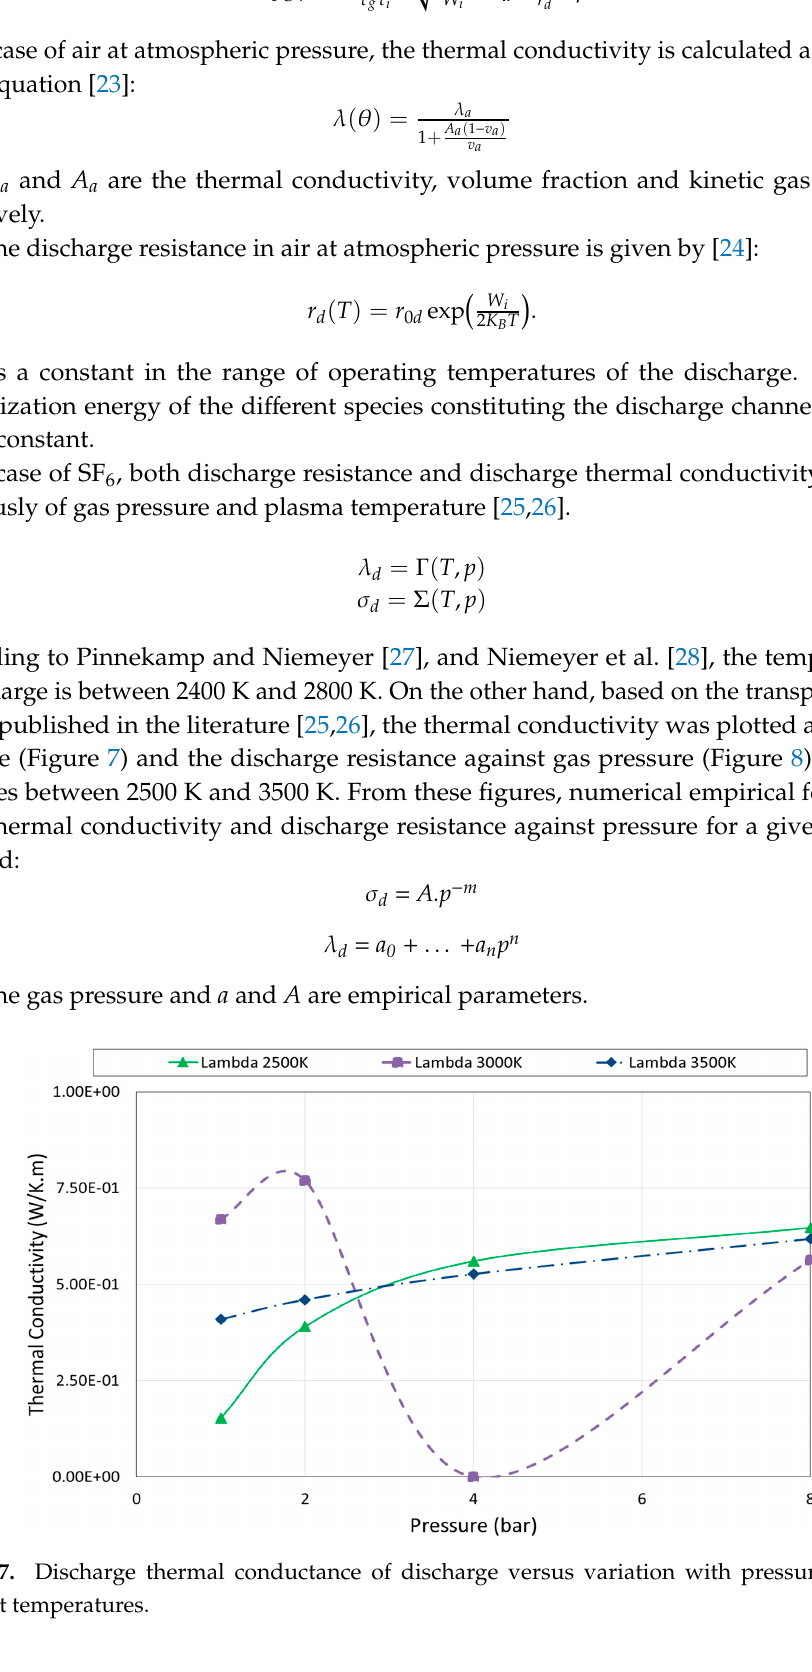
Figure 8. Discharge resistance variation versus pressure with different temperatures at 2500 and 3000 K, respectively. 4. Application To validate the proposed model, first the model was applied for the calculation of the flashover voltage of cylindrical epoxy insulators in air at atmospheric pressure. The second application will be for the same kind of insulator in SF 6 gas medium. The computed flashover voltages are compared